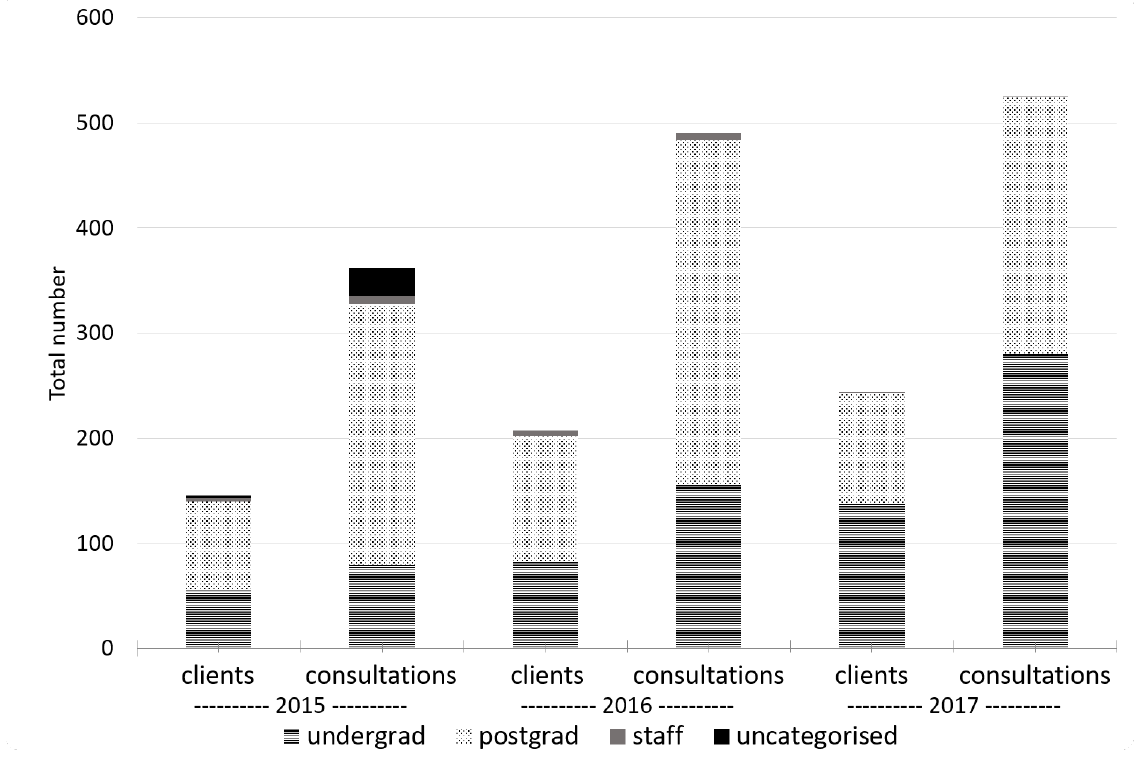
Figure 3 : The total numbers of individual clients seen, and consultations conducted by the Writing Lab each year, categorised according to the level of the client (2015 to